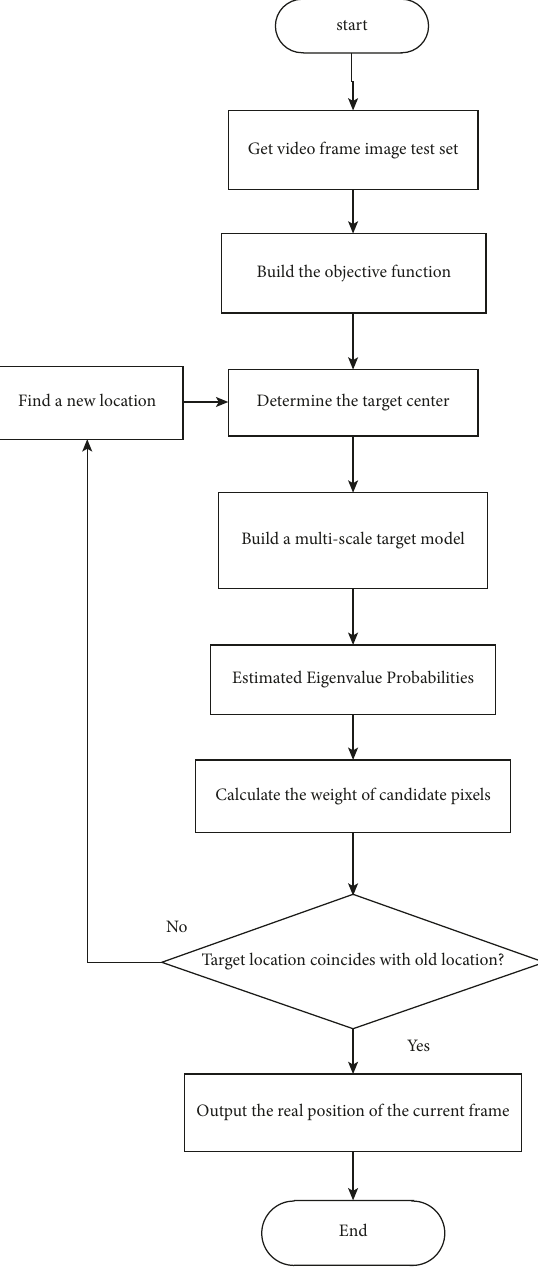
Figure 2: Flowchart of multiscale stable target